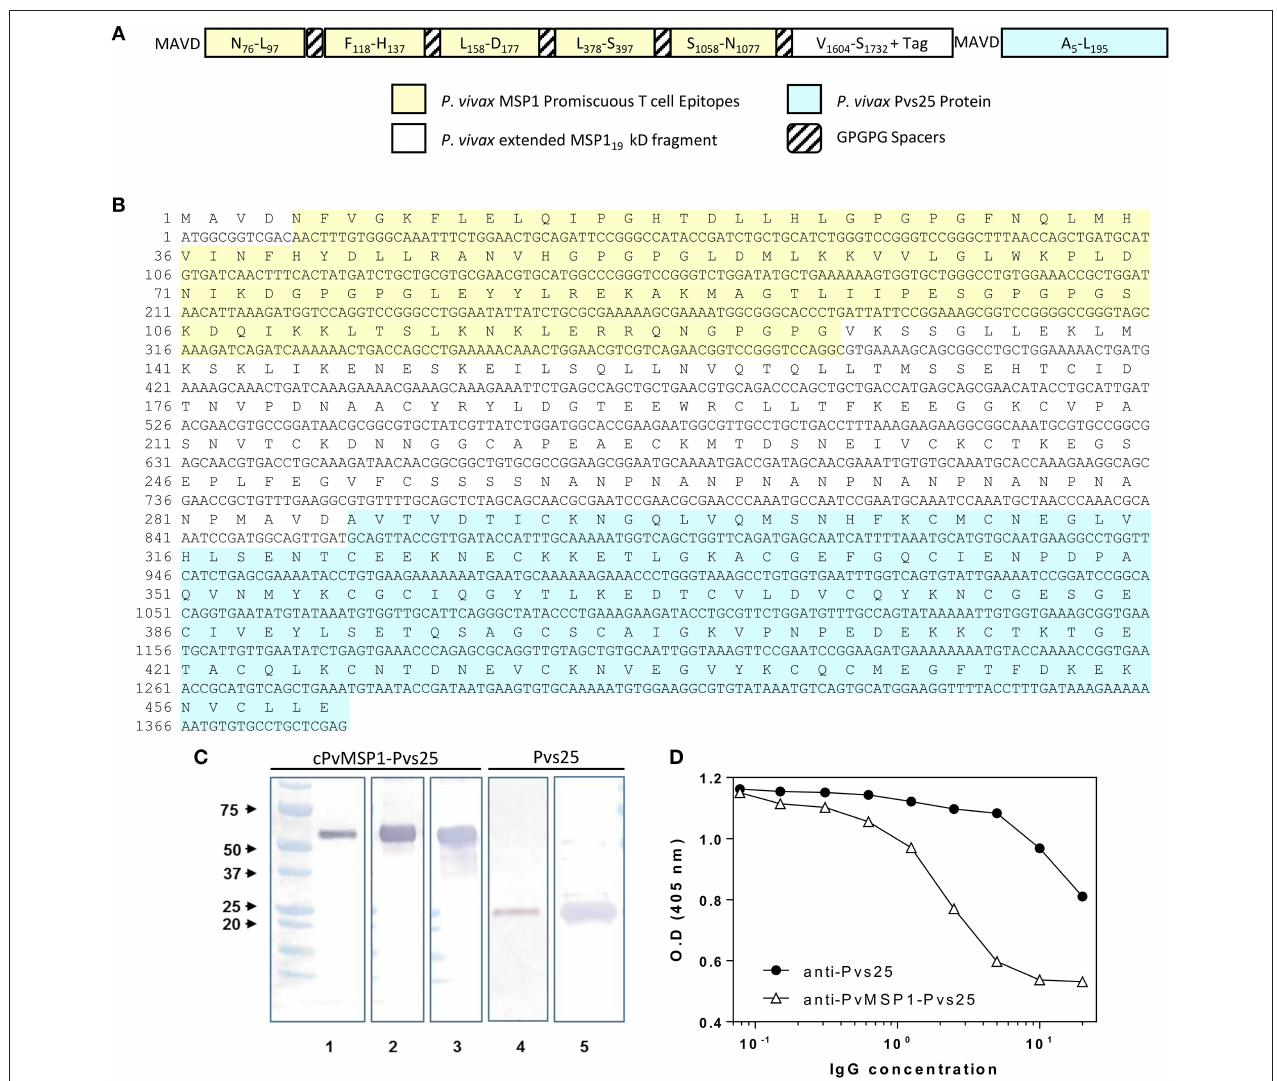
FIGURE 1 | cPvMSP1-Pvs25 protein structure, sequence, and characterization. (A) cPvMSP1-Pvs25 structure. This protein includes five promiscuous T cell epitopes of cPvMSP1 (yellow), each separated by a GPGPG spacer (diagonal lines). The promiscuous T cell epitopes are linked to a fragment derived from P. vivax MSP1 33 and the entire P. vivax MSP1 19 kD fragment (white), and the P. vivax Pvs25 protein (blue), with each separated by GPGPG spacers (diagonal lines). (B) cPvMSP1-Pvs25 amino acid sequence is shown in single letter code. The carboxyl-terminal (H) 6 tag provided by the vector was not included in the sequence. The yellow shaded area shows the region of the chimeric protein that contains the promiscuous T cell epitopes. The blue shaded area shows the P. vivax Pvs25 protein. (C) Western blot analysis of the purified cPvMSP1-Pvs25 (lanes 1–3) and the purified Pvs25 proteins (lanes 4 and 5). Each protein was run as separate PAGE gels using 1.0 µ g total of purified protein under reducing conditions, and blots were stained with individual antibodies. Full uncut blots are shown in Supplementary Figure 1 . Samples were incubated with following antibodies: Lane 1 and 4, the monoclonal antibody N1-1H10 which targets Pvs25; lane 2 and 5, an anti-His-Tag monoclonal antibody targeting the C terminal tags of the cPvMSP1-Pvs25 and Pvs25 proteins; lane 3, the monoclonal antibody 2A10 which targets the cPvMSP1C terminal tag. The molecular weight markers (BioRad) are indicated. (D) Polyclonal anti-cPvMSP1-Pvs25 and anti-Pvs25 elicited in rabbits compete for binding with the transmission blocking monoclonal antibody N1-1H10. Fixed amounts of N1-1H10 (1 µ g) were tested with 2-fold dilutions of purified rabbit IgG using Pvs25 as antigen. O.D. values (y-axis) are shown for anti-Pvs25 in closed circles and anti-cPvMSP1-Pvs25 in open triangles using polyclonal antibodies ranging from 0.078ng/ml to 20 µ g/ml (x-axis). Data are presented as geometric mean